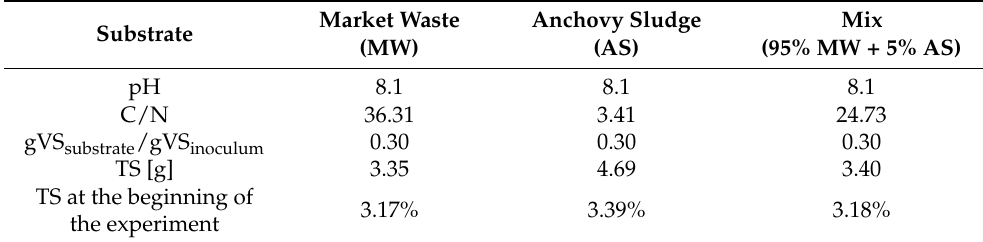
Table 2. BMP design of